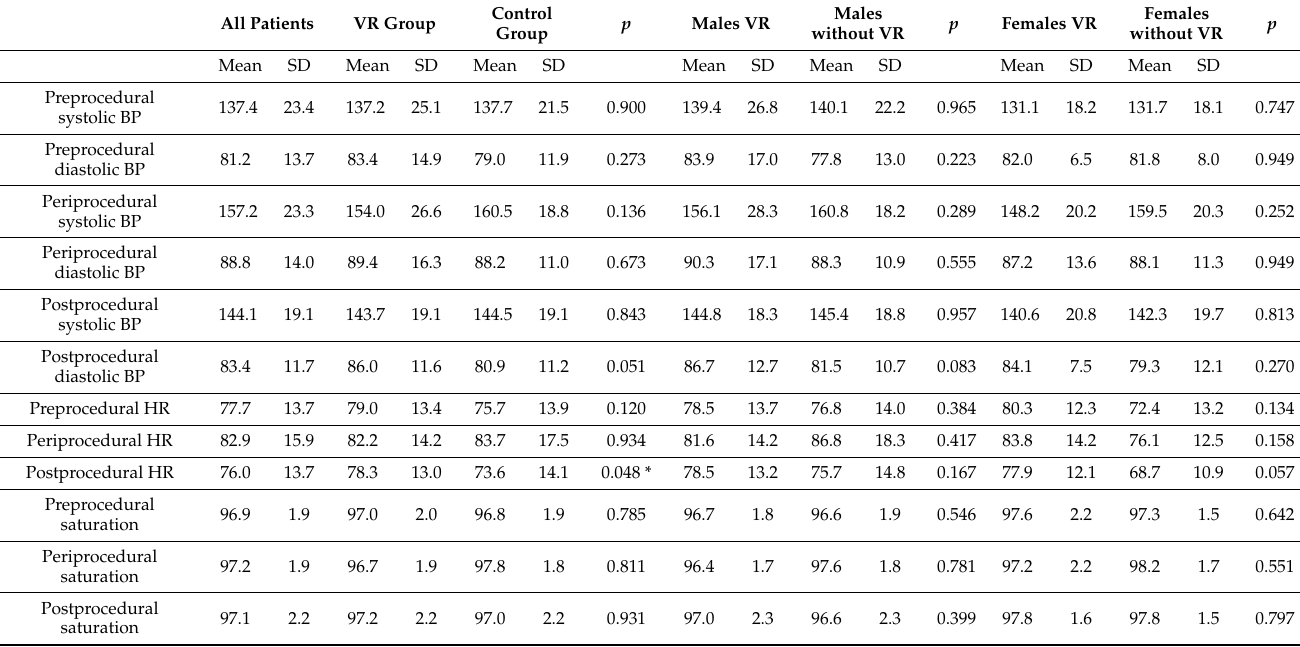
Table 3. Homeostasis parameters at various study timepoints.